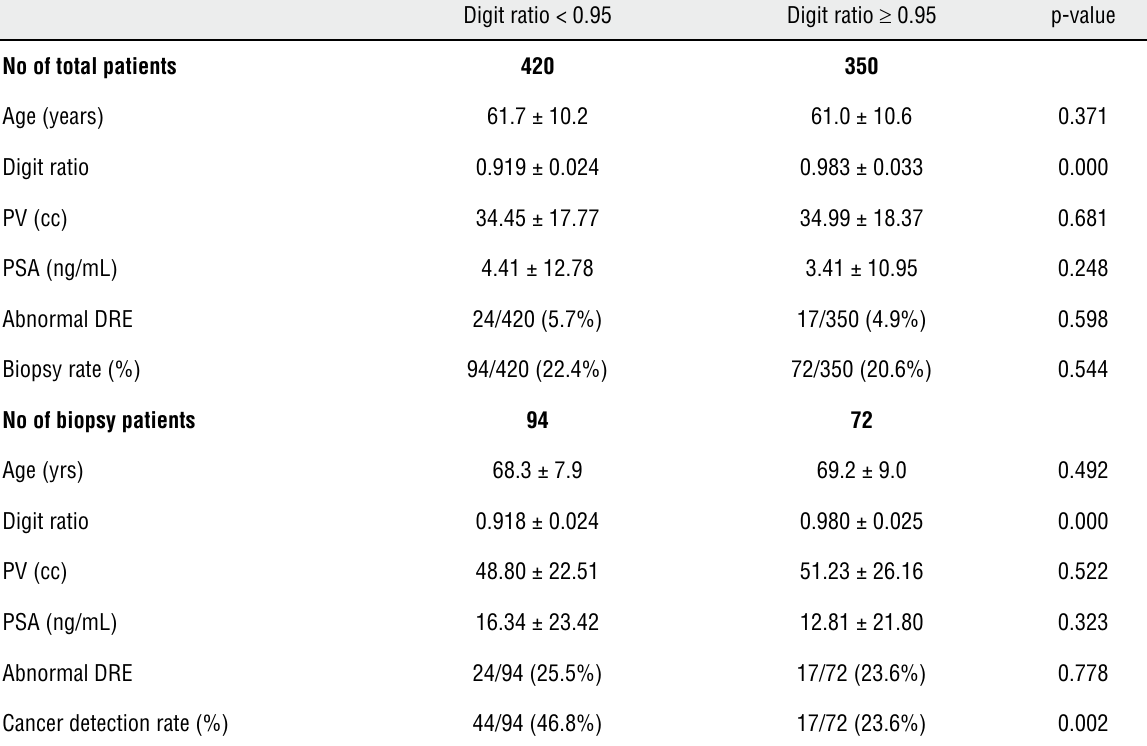
Table 3 - Comparison of the study variables between the two studied